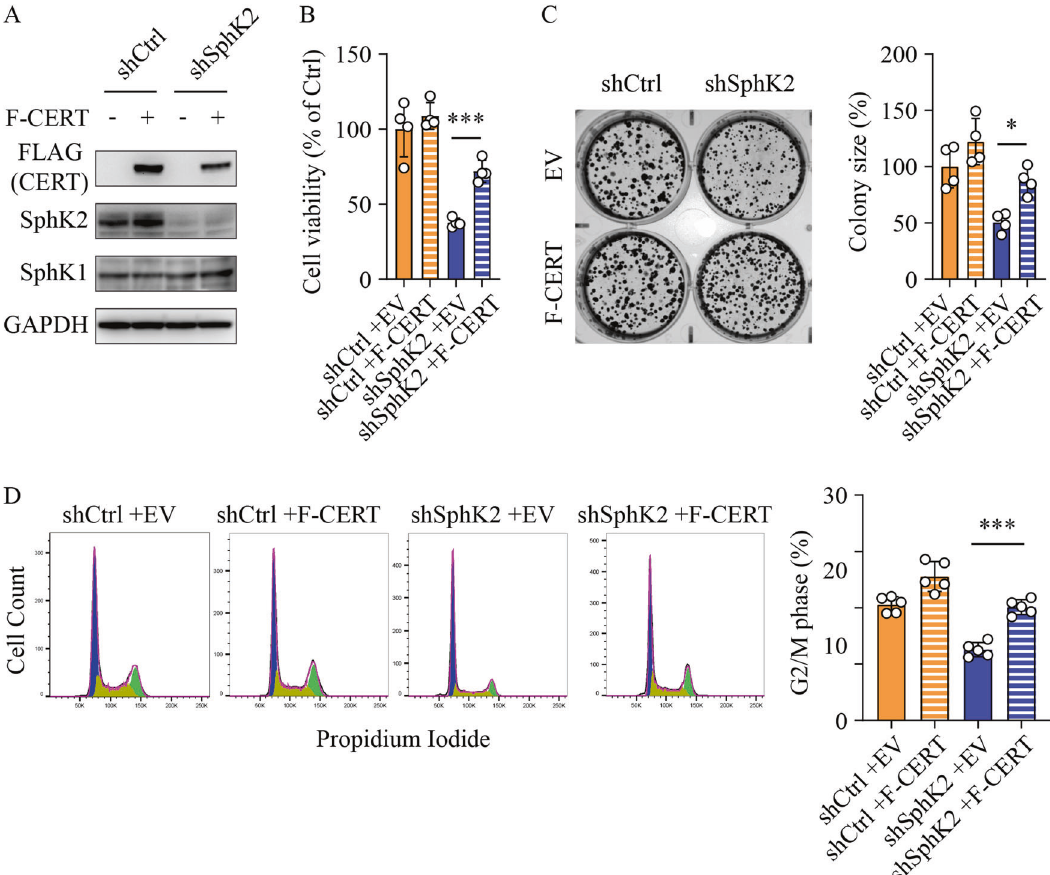
Fig. 6 Overexpression of CERT reversed the anti-cancer effects of SphK2 de fi ciency. Huh7 hepatic cells were transduced with lentiviral- based short hairpin RNA (shRNA) to stably knock down SphK2 and then transiently transfected with FLAG-tagged CERT, prior to the treatment with a combination of free fatty acids (200 µM palmitate + 400 µM oleate). A Western blotting analyses of the indicated proteins. B Cell viability was determined by MTS assay in cells treated with FFA for 48 h; n = 4. C Colony formation assay was performed over ten days of cell culture in the presence of FFA. Transfection of FLAG-tagged CERT was re-performed on day 5 of the culture to maintain the CERT expression. The size of colonies was quanti fi ed; n = 4. D Cell cycle phases were examined in cells treated with FFA for 24 h, using fl ow cytometry with propidium iodide staining. G 0 /G 1 , S, and G 2 /M phase populations were estimated using FlowJo software and are indicated in blue, yellow, and green in histograms, respectively. The percentage of the G 2 /M phase, indicative of cell cycle progression, was analyzed; n = 5. Data are expressed as mean ± SD. * p < 0.05; *** p < 0.001; as